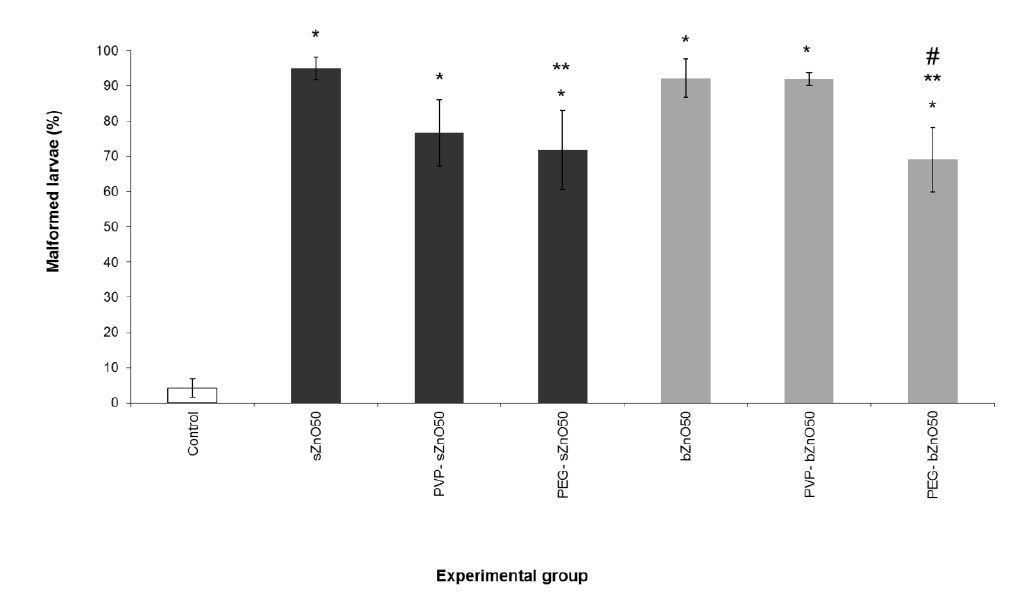
Figure 4. Comparative FETAX malformation percentages after exposure of embryos to nude and polymer-coated sZnO and bZnO at 50 mg/L. Dark grey = sZnO-exposed larvae; light grey = bZnO-exposed larvae. Bars = SEM; * statistically different from the control at p < 0.001; ** statistically different from the corresponding nude nanoparticles at p < 0.05; # statistically different from the corresponding PVP-coated bZnO at p < 0.05, ANOVA + Fisher LSD